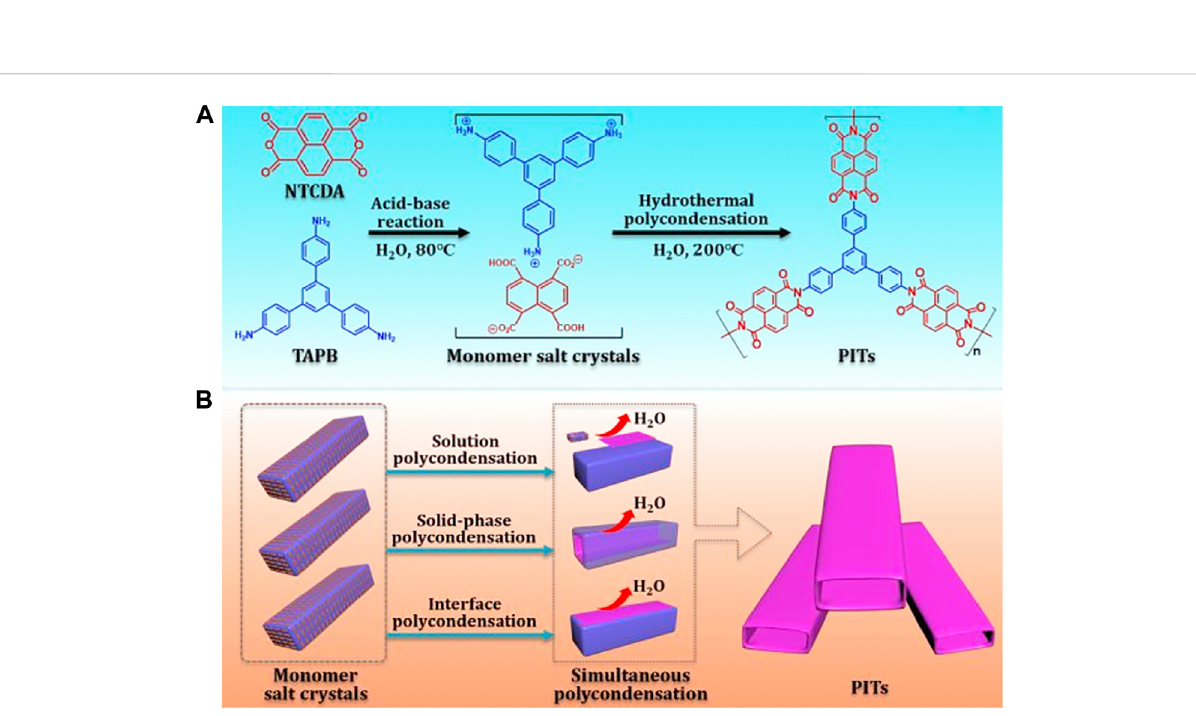
FIGURE 13 Schematic illustration of (A) two-step synthetic routes and (B) the proposed formation mechanism of polyimide tubes (Lei et al.,